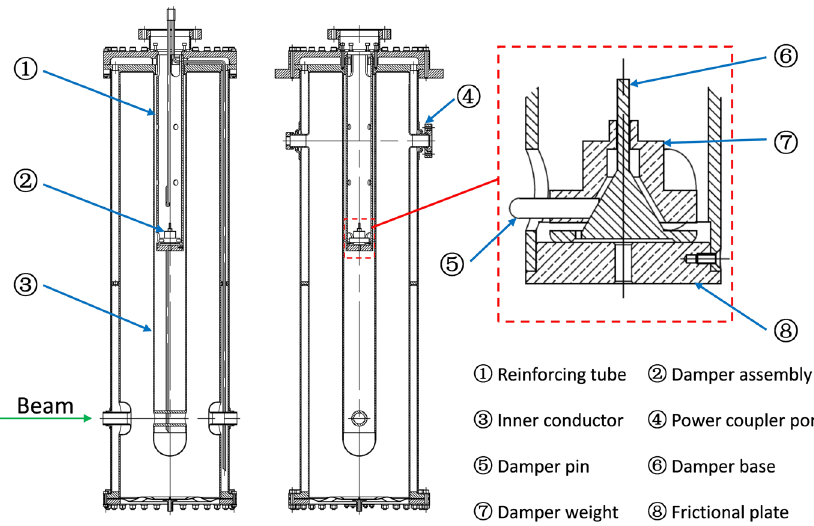
FIG. 1. The drawing of 106 MHz QWR with details of the damper